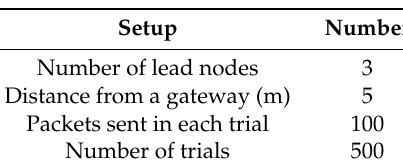
Table 1. Radio test setup.